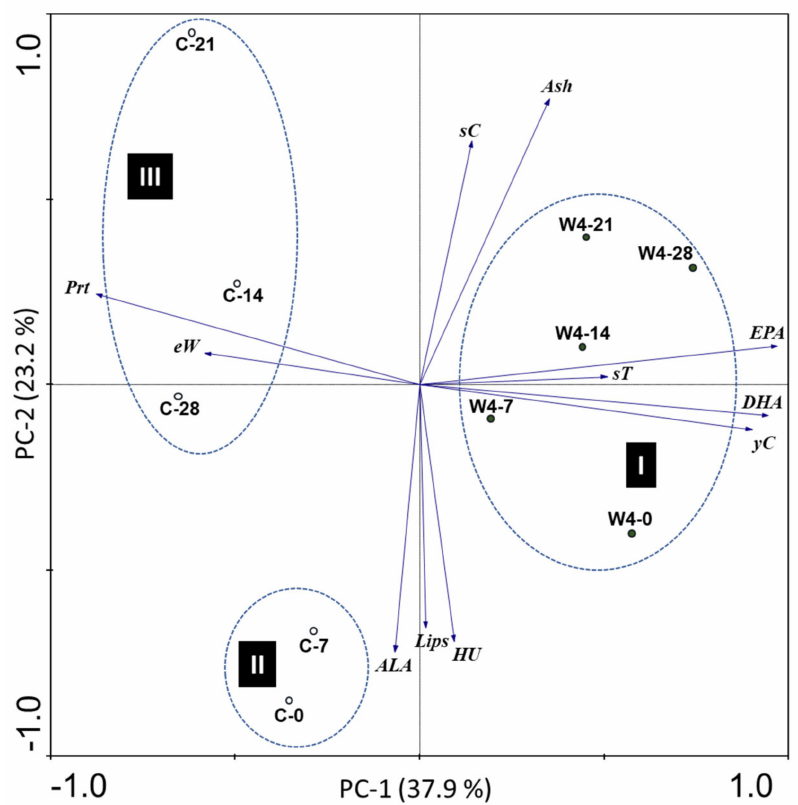
Figure 5. Principal component analysis (PCA) biplot of egg samples along the shelf-life, concerning 11 parameters: amounts of the fatty acids EPA, DHA and ALA; protein (Prt), lipids (Lips) and ash (Ash); Yolk colour (yC); Shell colour (sC); shell thickness (sT); egg weight (eW) and egg protein quality (HU). C-0; C-7; C-14; C-21 and C-28—Eggs from hens fed with standard diet, after zero (0), 7, 14; 21 and 28 days of storage. W4-0; W4-7; W4-14; W4-21 and W4-28—eggs from hens fed with N. oceanica supplemented diet, after 0, 7, 14; 21 and 28 days of storage. PC-1 and PC-2